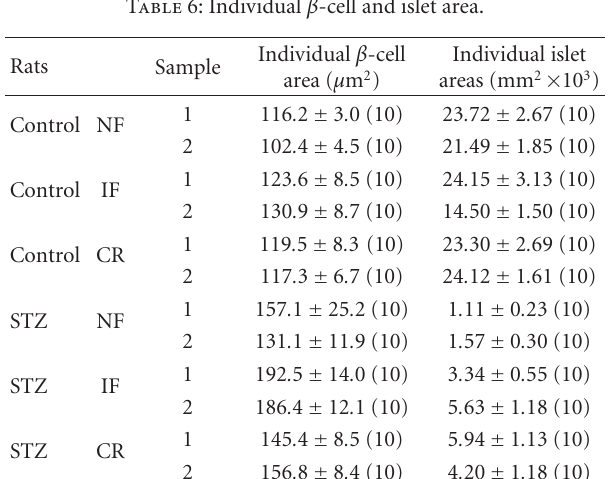
Table 6: Individual β -cell and islet